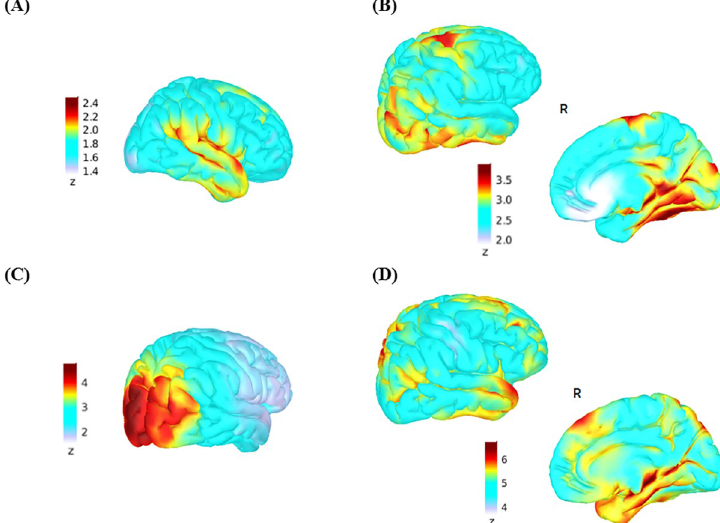
Fig 5. Source estimation for EEG activity in response to the oddball (A, B) and Simon tasks (C, D). Current density maps for both tasks were normalized in relation to values during the baseline period prior to stimulus presentation (-200 to 0 ms). Z-scores are with respect to the baseline period. (A) Current density maps during early auditory processing in response to the large deviant tone between 70 and 90 ms post stimulation. (B) Current density maps indicating sources for the P300 peak activations (280–400 ms) in response to the large deviant tone. The P300 evoked during the oddball task showed current density foci peaking in middle and inferior temporal gyri, posterior cingulate, temporal-parietal junction and the posterior superior frontal gyrus, principally on the right. (C) Early visual activity between 90–120 ms in response to incongruent stimuli. (D) Peak activations during the P300 time window in response to incongruent stimuli (300–550 ms). Lateralization to the right hemisphere also occurred for the P300 of the Simon task. As in the oddball task, activity localized to the temporal-parietal junction, but otherwise engaged different cortical regions: the anterior cingulate, middle and anterior-superior frontal gyrus and superior temporal gyrus. R = right hemisphere.